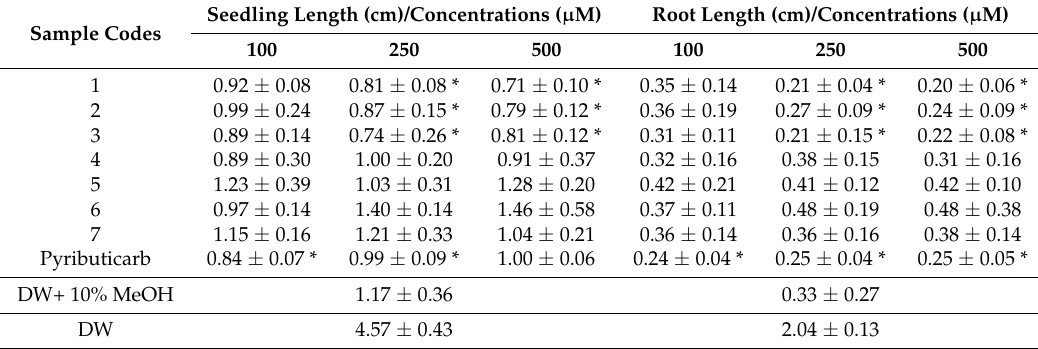
Mean values ± SD from triplicate separated experiments are shown. * Significantly different from DW+ 10% MeOH based on the DMRT (Duncan’s multiple range test) ( p <